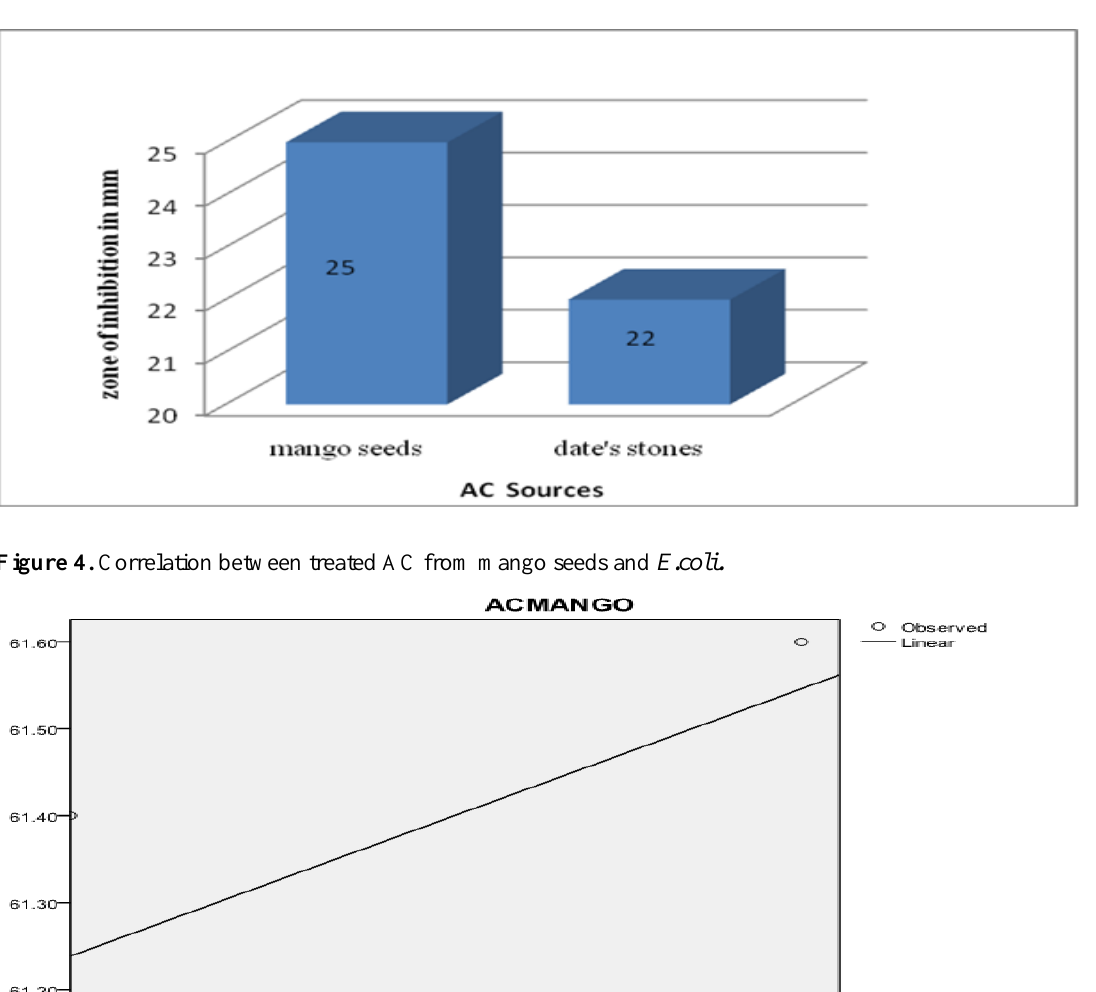
Figure 3. Showing that antibacterial activity of AC from mango seeds and date’s stones against E. faecalis .